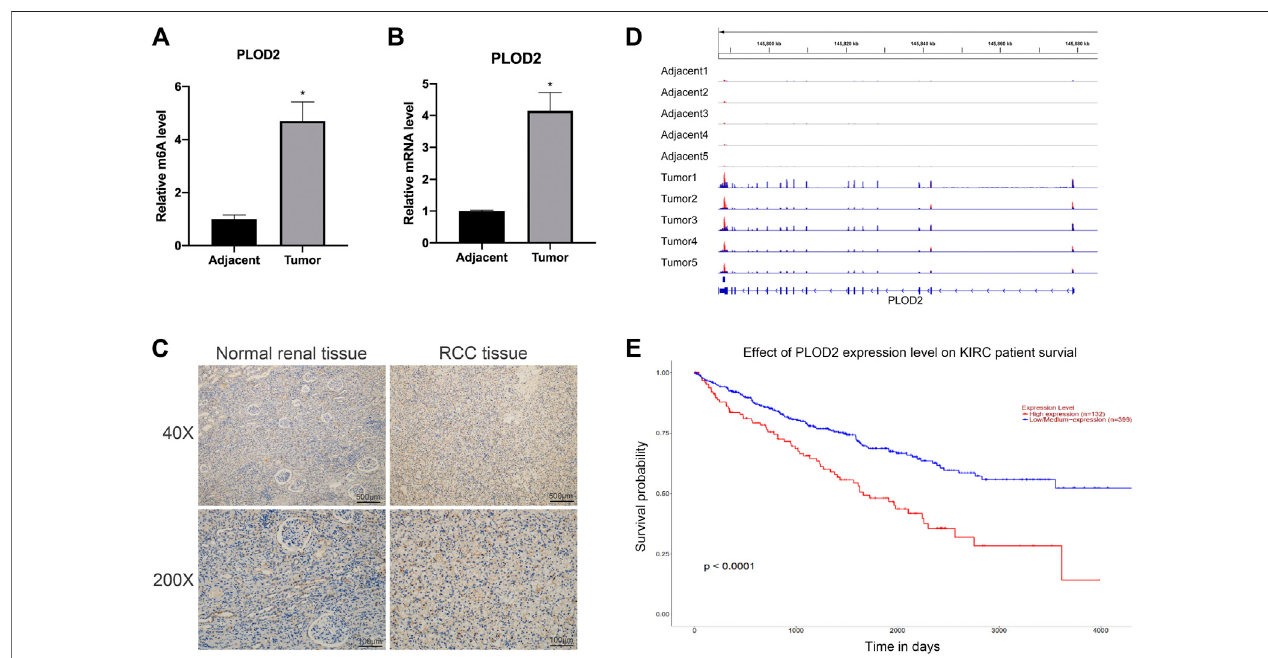
FIGURE 1 | The mRNA and m6A methylation levels of PLOD2 were signi fi cantly increased in RCC tissues compared to adjacent tissues. (A) M 6 A enrichment of PLOD2 mRNA in fi ve pairs of RCC tissues and matched adjacent tissues was measured by MeRIP-qPCR analysis. (B) PLOD2 mRNA expression levels in tumor and adjacent tissues were detected by RT-qPCR. (C) Representative IHC stains of PLOD2 in RCC tumor and adjacent tissues. (D) The m 6 A abundances on PLOD2 mRNA transcripts in fi ve pairs of tumor and adjacent tissues by m 6 A-RIP-seq. (E) Survival analysis of PLOD2 expression in RCC patients. * p < 0.05.